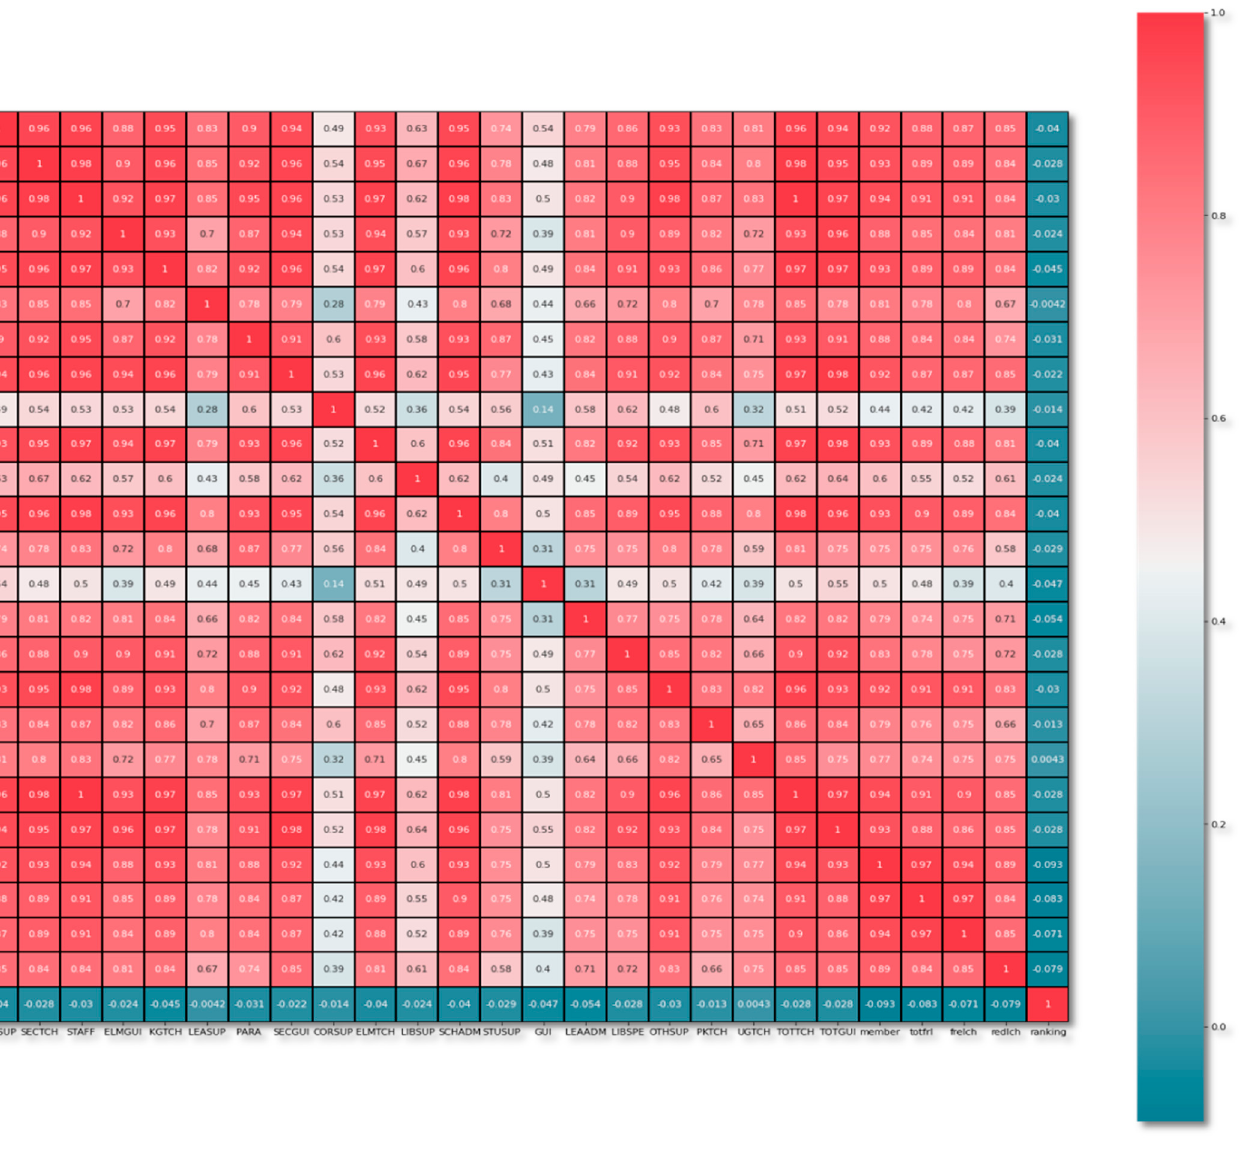
Figure 9. Result of the heatmap tool.